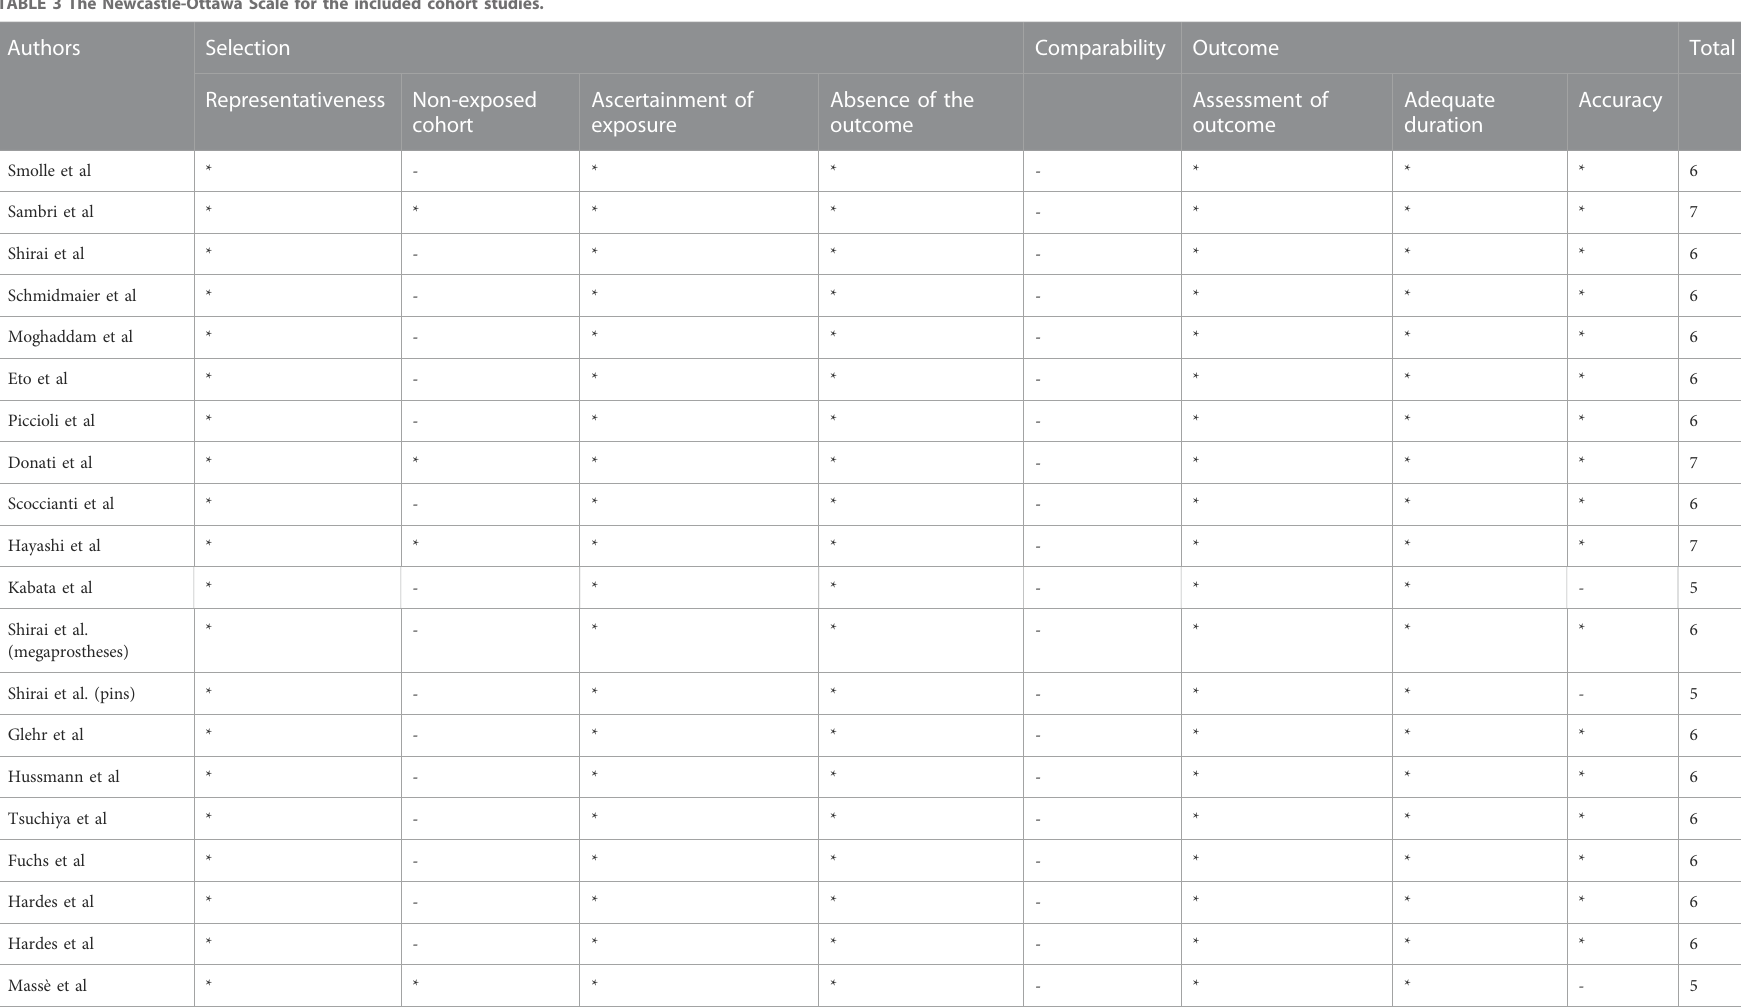
TABLE 3 The Newcastle-Ottawa Scale for the included cohort